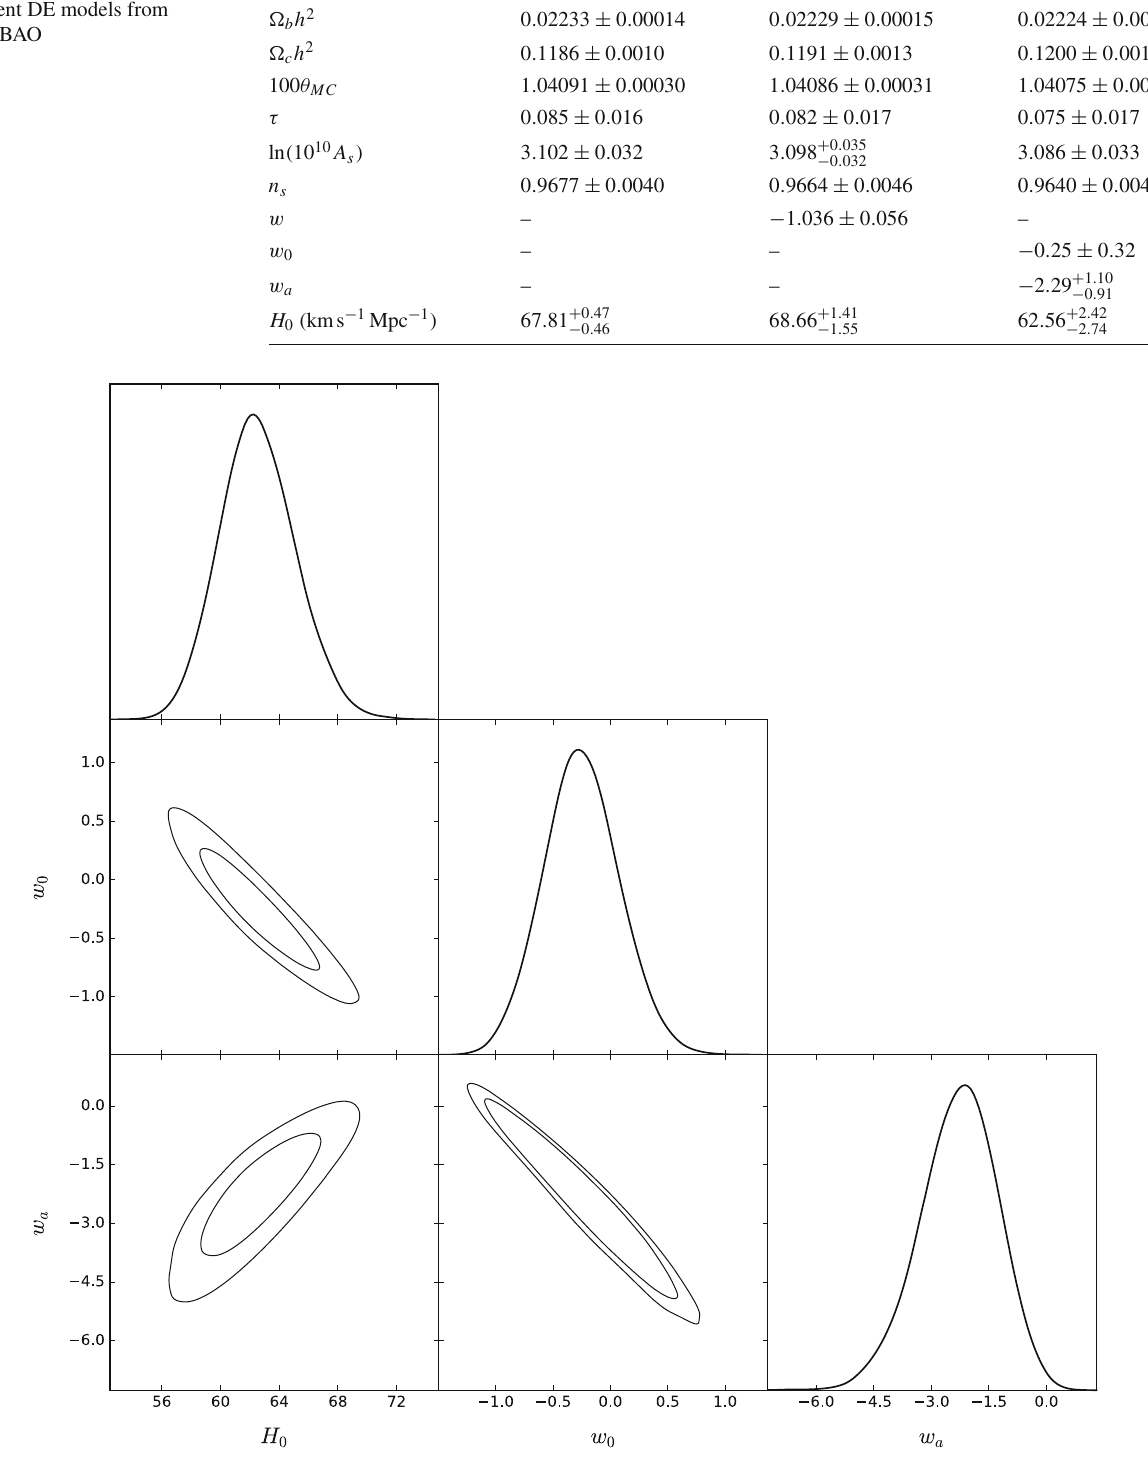
Table 1 The 68% limits for the cosmological parameters in different DE models from P15 + BAO